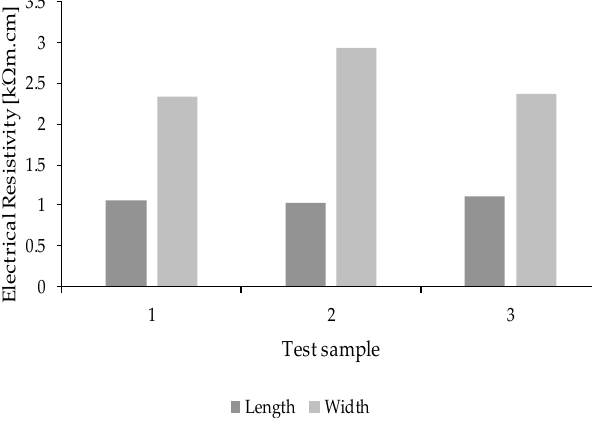
Figure 8. Results of the electrical resistivity tests of the three specimens carried out in the two directions.